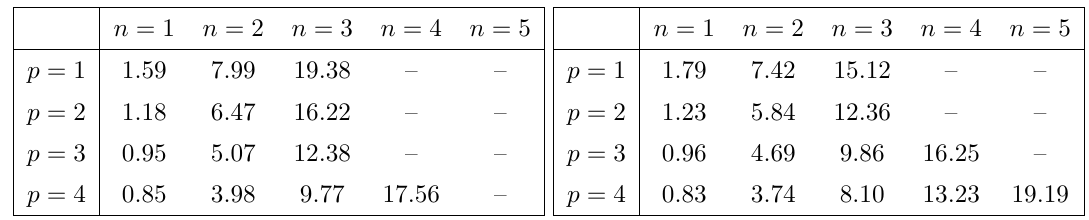
Table 3 . Critical masses for the full Skyrme model with the Lin-Piette potentials. No value denotes that the critical point occurs above m = 20. Left: (cid:15) = 0. Right: (cid:15) = 1.